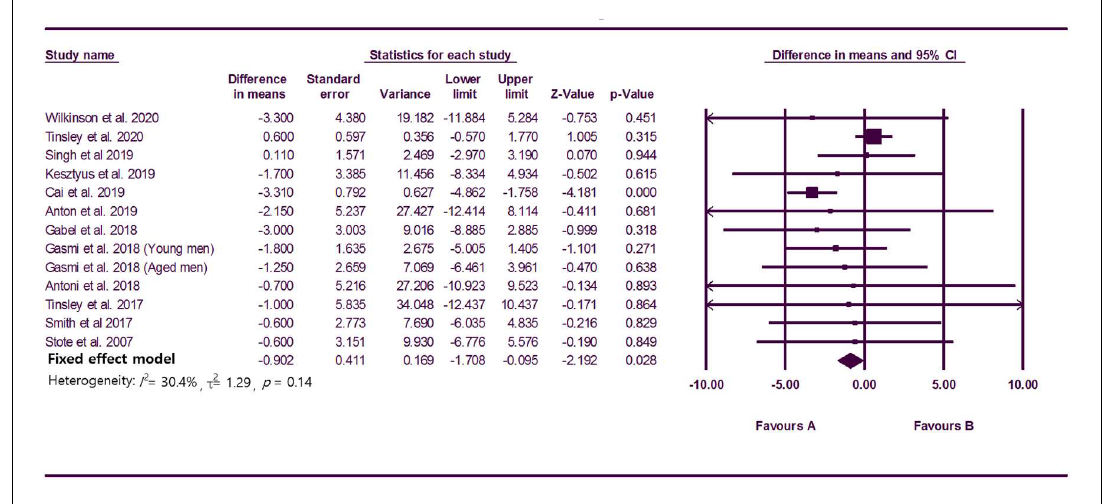
Figure 3. Forest plots summarizing the effect of TRE on body weight compared to baseline.